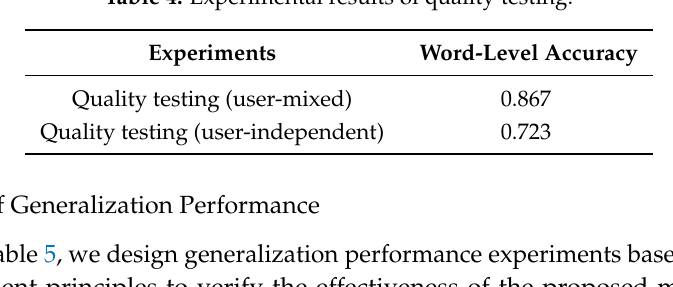
Table 4. Experimental results of quality